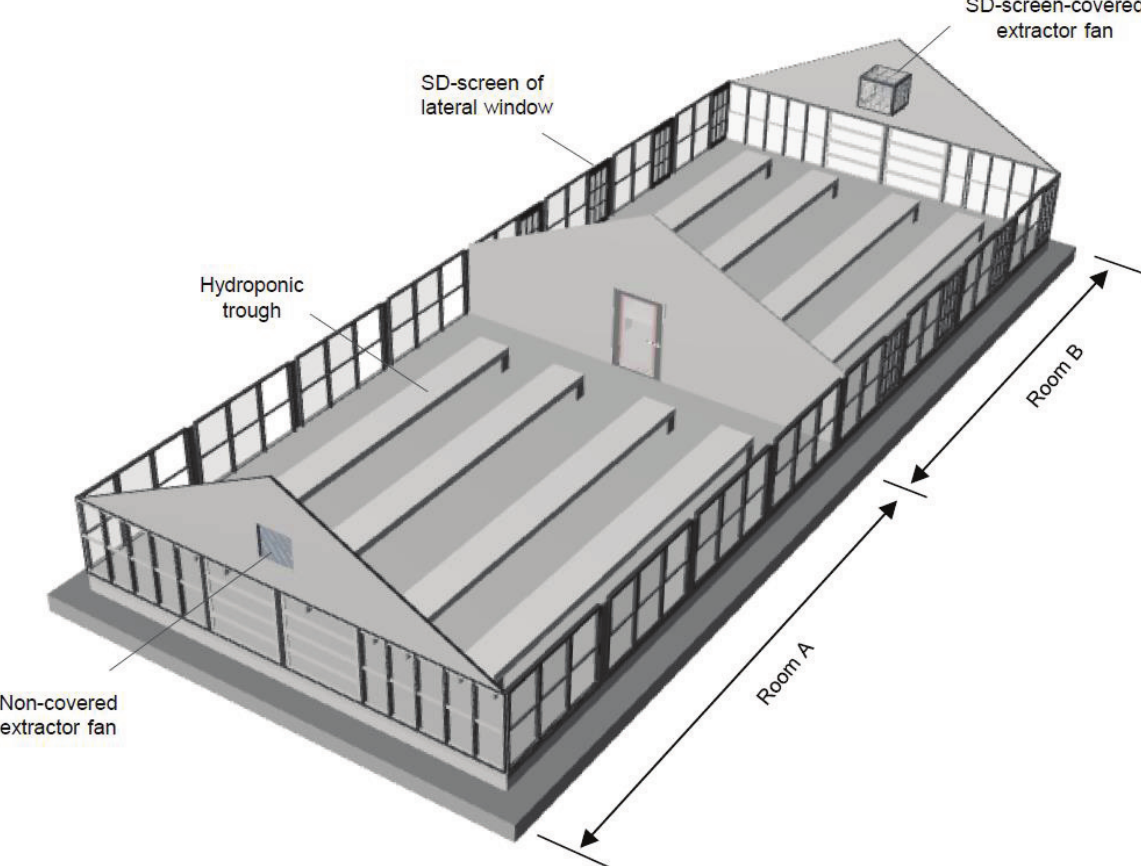
Figure 2. Three-dimensional diagram of the greenhouse, which was divided into two rooms by means of wall partitions. SD screens were attached to the frames of lateral windows on both sides of the right room (room B). The left room (room A) of the divided greenhouse was unguarded, and whiteflies maintained therein propagated on hydroponic tomato